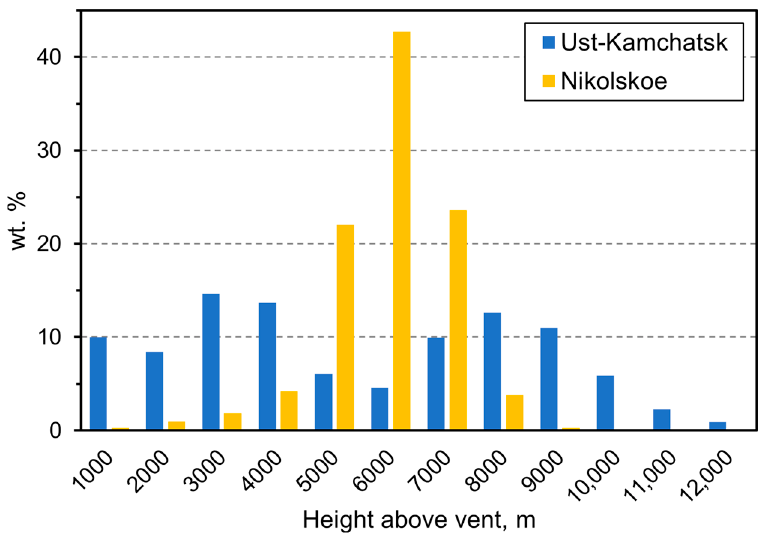
Figure 10. The percentage ration of the ash mass fallen from the different parts of the eruptive col- umn.